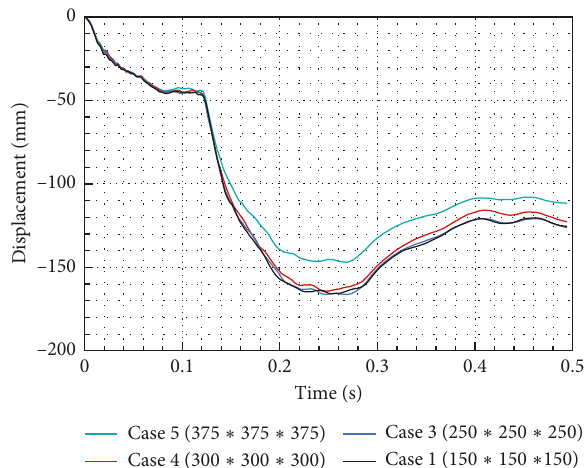
Figure 11: Displacement of the containment in the impact region for various element